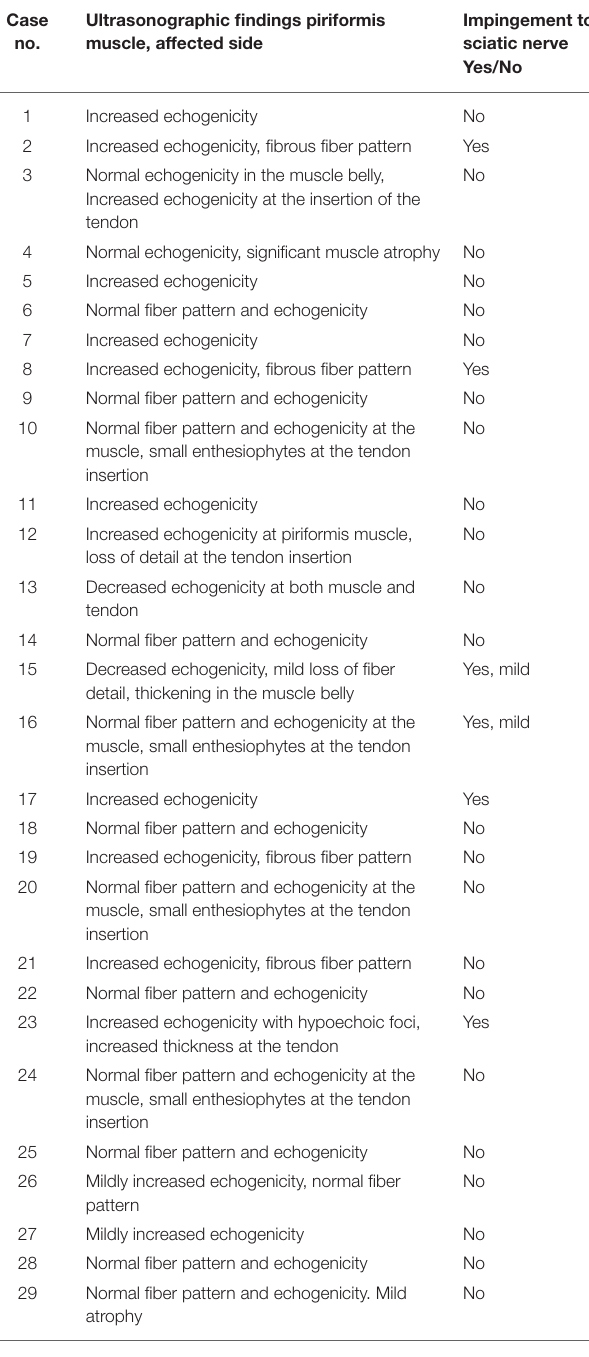
TABLE 3 | Ultrasonographic findings of the piriformis muscles and tendons on the affected side. Case